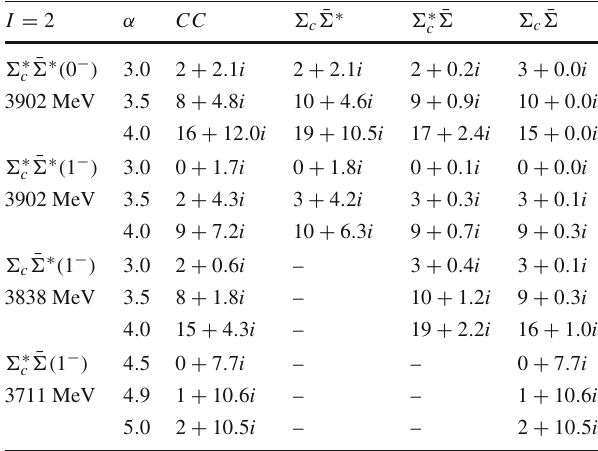
Fig. 6 Binding energies of isotensor bound states from the charmed- antistrange interactions with the variation of α in single-channel calcu- lation Table 9 The masses and widths of isotensor charmed-antistrange molecular states at different values of α . Other notations are the same as Table